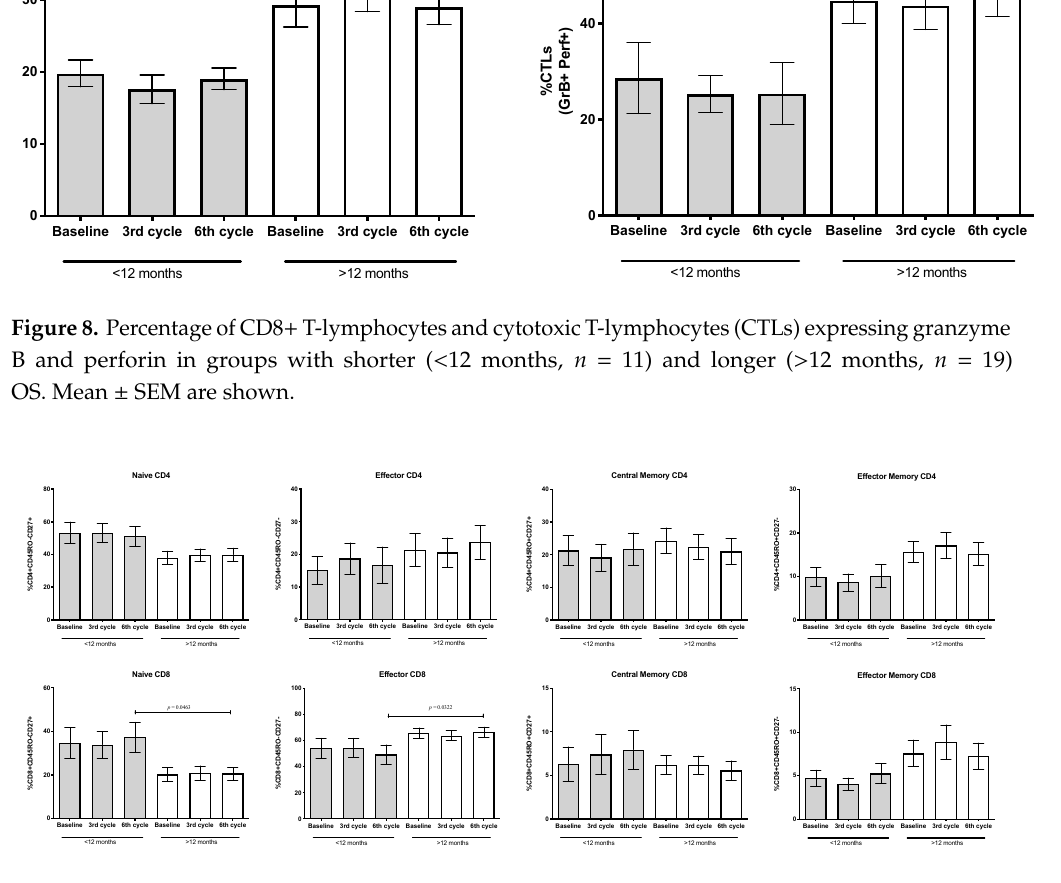
Figure 8. Percentage of CD8+ T-lymphocytes and cytotoxic T-lymphocytes (CTLs) expressing granzyme B and perforin in groups with shorter (<12 months, n = 11) and longer (>12 months, n = 19) OS. Mean ± SEM are shown.